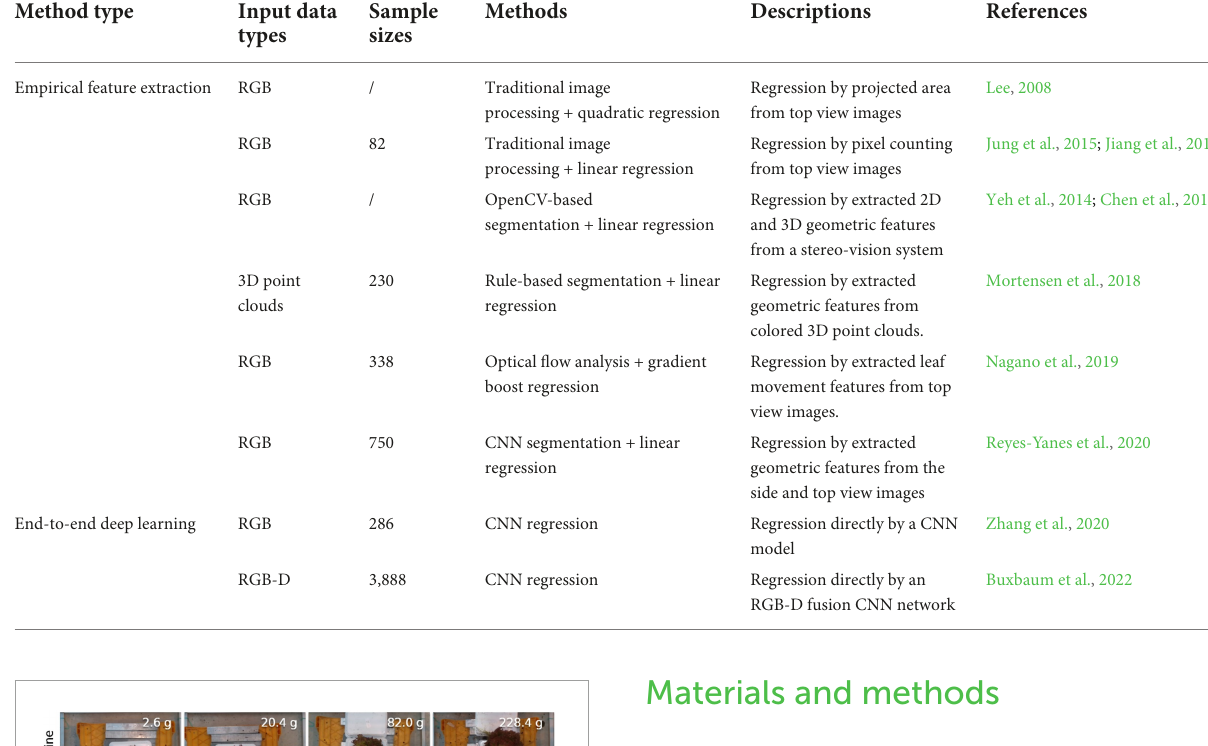
TABLE 1 An overview of existing image-based methods for lettuce fresh weight monitoring.